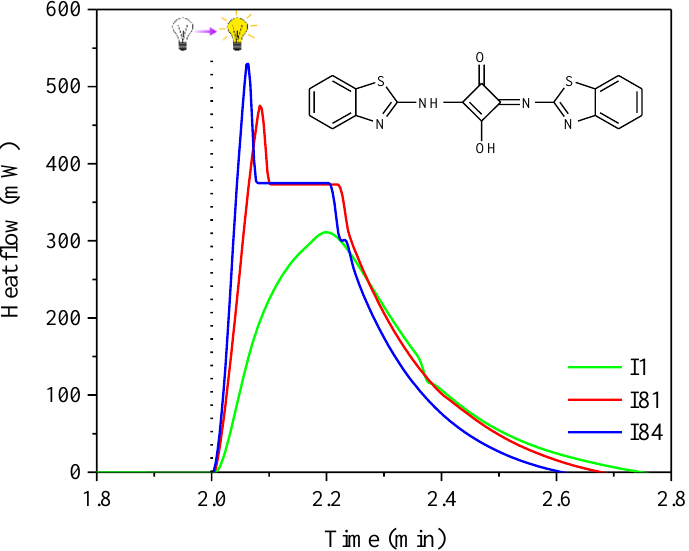
Figure 16. Kinetic profiles recorded during radical polymerization of trimethylolpropane triacrylate (TMPTA) initiated by two-component photoinitiating system consisting of SQM1 as sensitizer in the presence of various co-initiators, marked on the figure. Experimental conditions: concentration of PI—5 × 10 − 3 M; light intensity—30 mW × cm − 2 . Reproduced from ref. [113], which was published under a CC BY